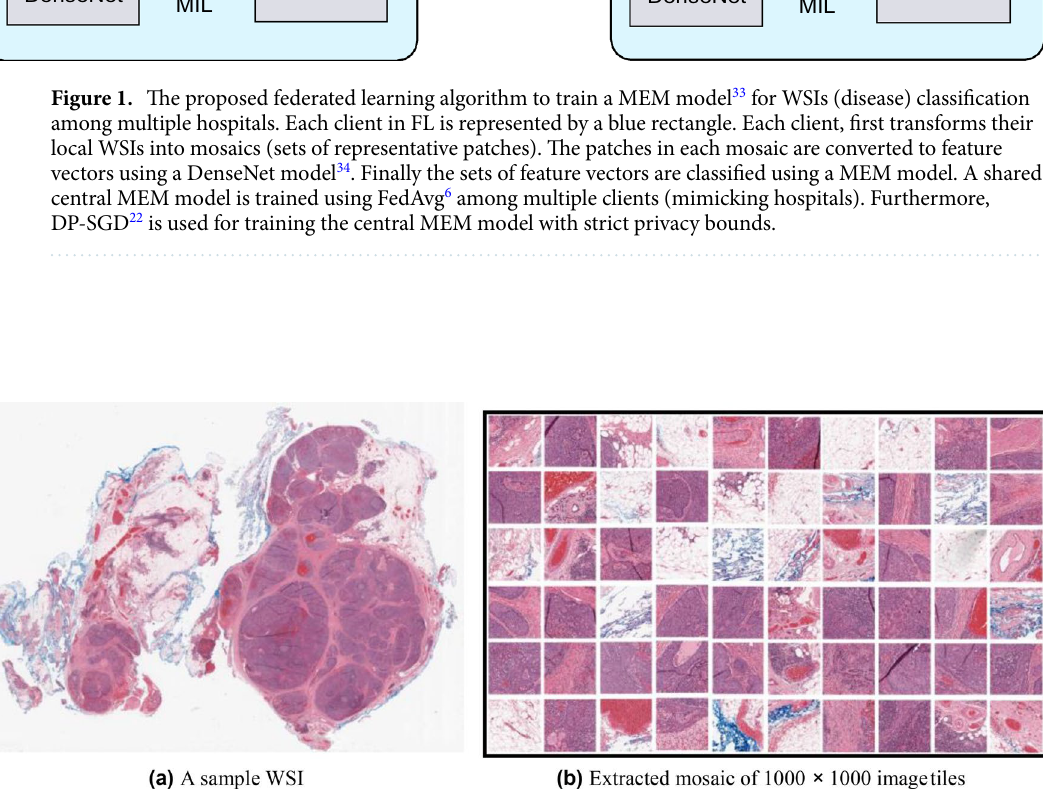
Figure 2. Illustration of a sample WSI and its mosaic extracted using the approach in Kalra et al. 35